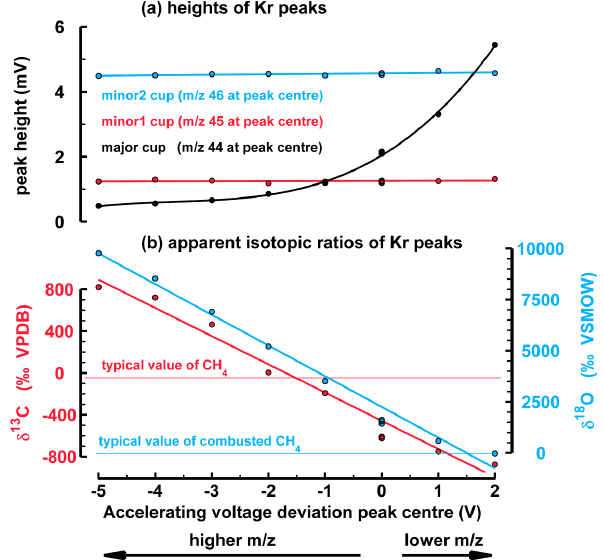
Fig. 5. Influence of slight changes in the accelerating voltage on the peak heights and apparent isotopic signatures of Kr peaks. Results of Kr injection into GC flow carried out with the Bern system with the source focused to CO 2 . (a) The upper panel shows the measured peak heights for the three Faraday cups (major, minor1, minor2) of the Kr peak as a function of the accelerating voltage; dots represent measurements and lines a linear fit for minor1 and minor2, and a cubic fit for the major cup. (b) The lower panel shows the apparent isotopic composition ( δ 13 C in red and δ 18 O in blue) of the Kr interference calculated from the peak area of the Kr peaks; dots represent measurements and lines the linear